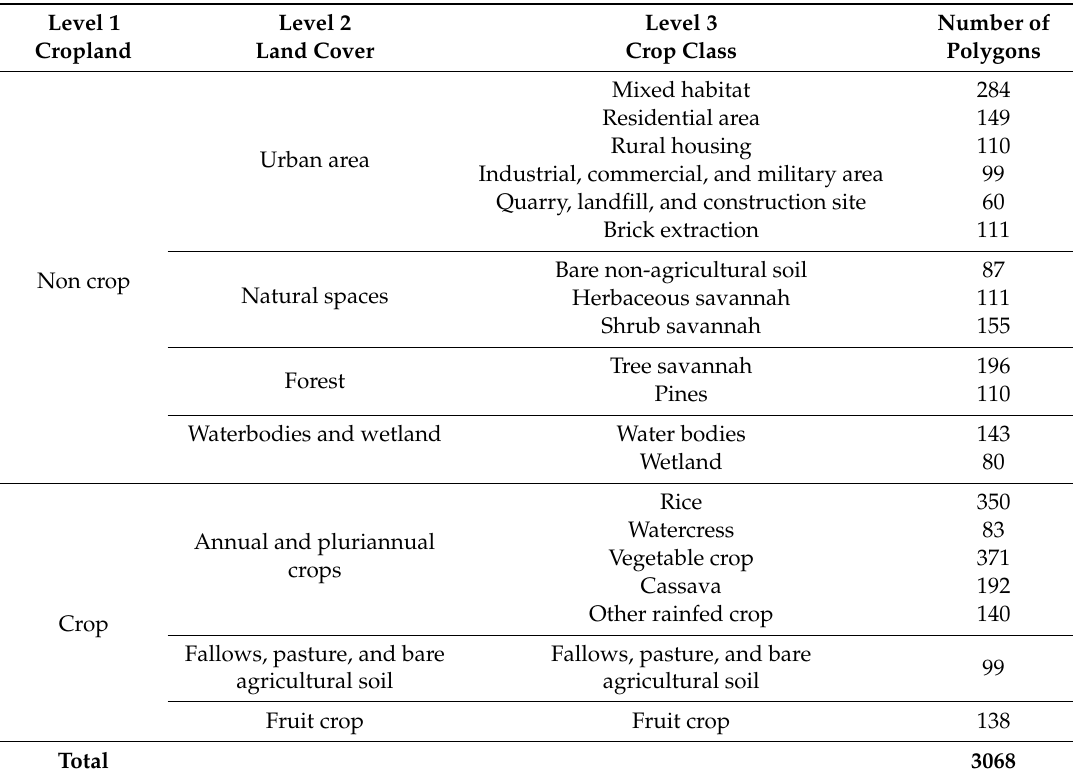
Table 1. Number of polygons per class in the learning database for level 3 of the